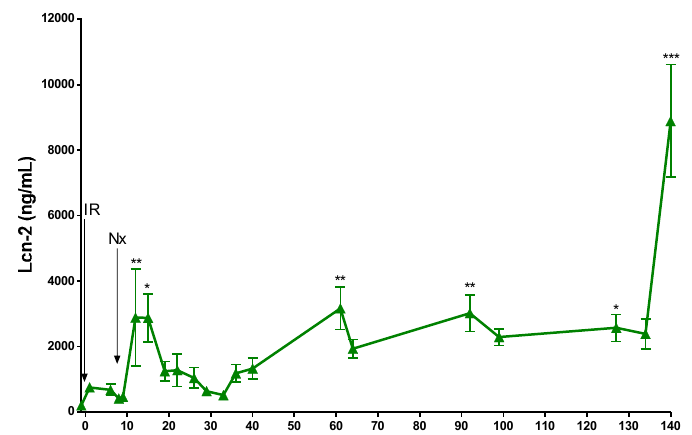
Figure 3. Plasma Lcn-2 of mice in the IR-Nx group in the long-term study. Data are expressed as mean ± SEM; one-way ANOVA with Tukey’s post hoc test; *: p < 0.05, **: p < 0.01 and ***: p < 0.001; day -1 vs. all other time points.